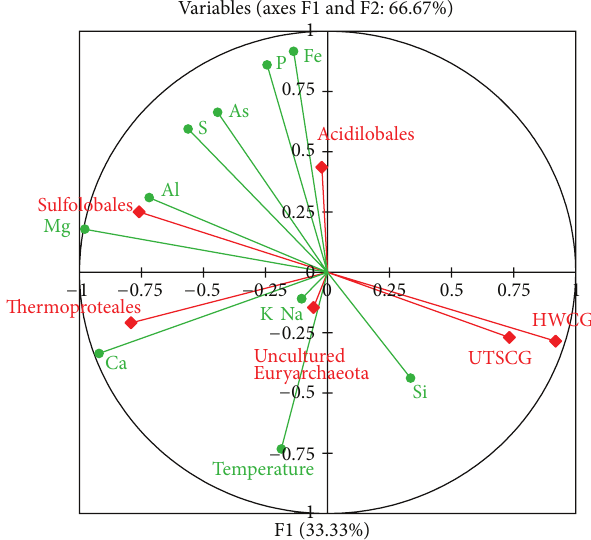
Figure 4: Canonical correlation analysis showing correlative relationships between environmental factors and proportions of individual archaeal groups. Archaeal groups were shown in abbreviations and rhombus. Environmental factors were shown in circle.